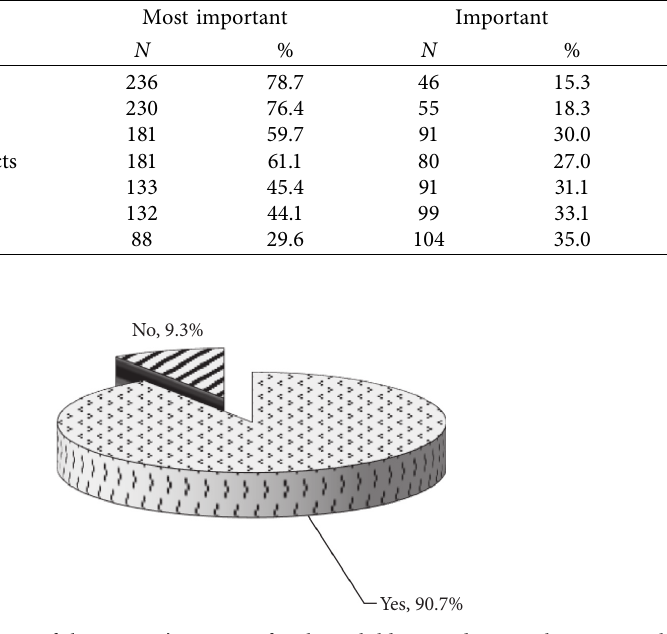
Table 5: Parents’ experiences from agricultural skills developed in their children in secondary schools.